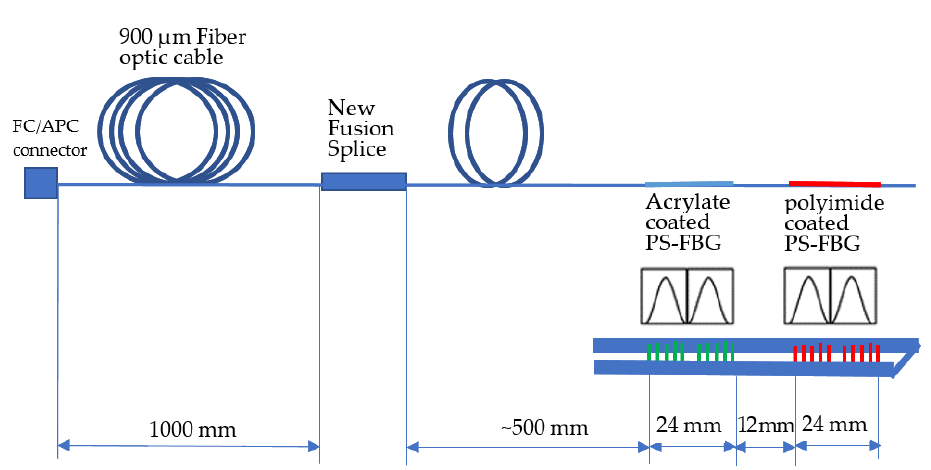
Figure 5. The ppm moisture sensor architecture and its connection. The separation between the narrow peaks in the composite plot is largest when there is no moisture. It relates inversely to ppm